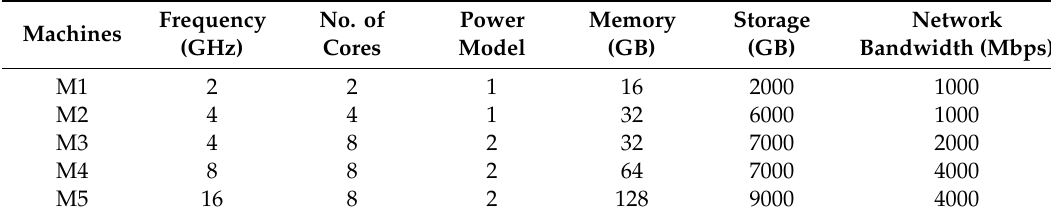
Table 1. Physical machine characteristics [24].